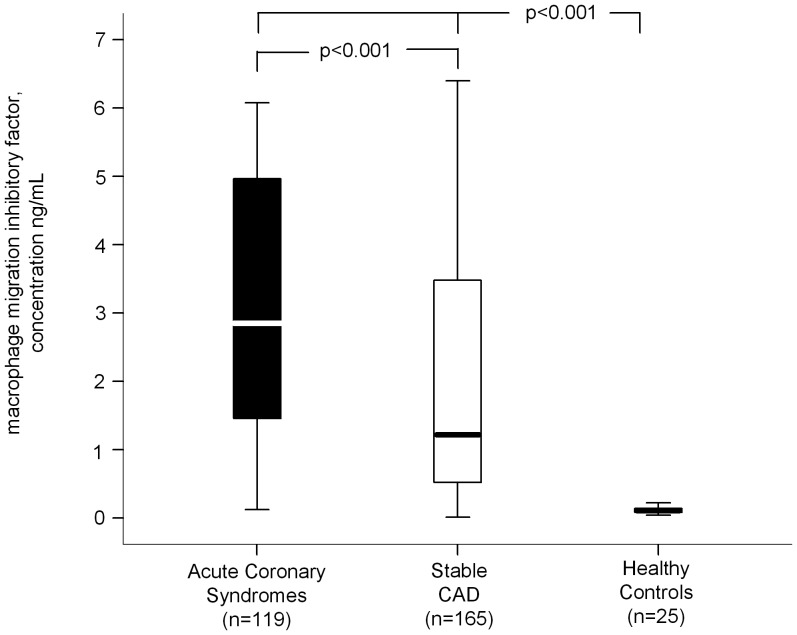
Boxplots showing MIF-levels according to acuity of CAD compared with healthy volunteers.